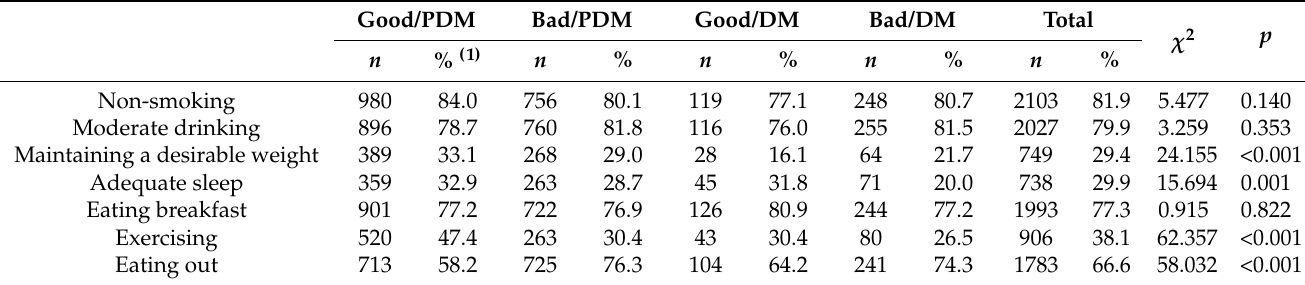
Table 2. Health behavior practice rate between